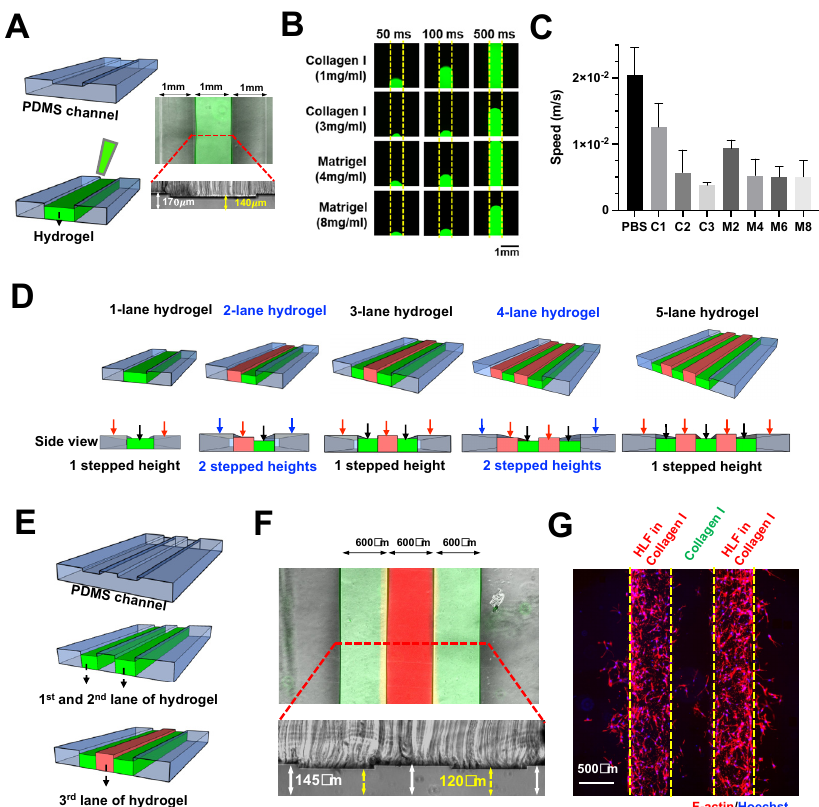
Figure 1. Scalable hydrogel patterning in enclosed microchannel using stepped height features. ( A ) Schematic illustration of stepped height-based hydrogel patterning in a single lane hydrogel chip. Overlaid fluorescence and brightfield image of the chip loaded with FITC-laden Collagen I (3 mg/mL) in the hydrogel channel (top). Cross-sectional view of the chip, white arrow indicates channel height of 170 µ m, while yellow arrows indicate channel height of 140 µ m (bottom). ( B ) Fluorescence images showing the gel loading process at different timepoints for Collagen I (1, 3 mg/mL, FITC-laden) and Matrigel (4, 8 mg/mL, FITC-laden). Yellow dotted line indicates the channel boundary. ( C ) Loading speed of 1 × PBS, Collagen I (1, 2, and 3 mg/mL), Matrigel (2, 4, 6, and 8 mg/mL) in the one-lane hydrogel chip. ( D ) Schematic illustrating the concept of multi-lane hydrogel confinement using a single stepped height for odd number of lanes, and two stepped heights for even number of lanes. Black arrows indicate the first-layer channels, red arrows indicate the second-layer channels, and blue arrows indicate the third layer channels. ( E ) Schematic of sequential three-lane hydrogel loading. ( F ) Overlaid fluorescence and brightfield image of the chip loaded with FITC-laden Collagen I (3 mg/mL) in the first and third lanes, and R6G-laden Collagen I in the second lane (middle). Cross-sectional view of the chip, white arrow indicates channel height of 145 µ m, while yellow arrows indicate channel height of 120 µ m (bottom). ( G ) Fluorescence image of the chip containing two lanes of HLF-laden Collagen I with a cell-free Collagen I in between. (F-actin–red,